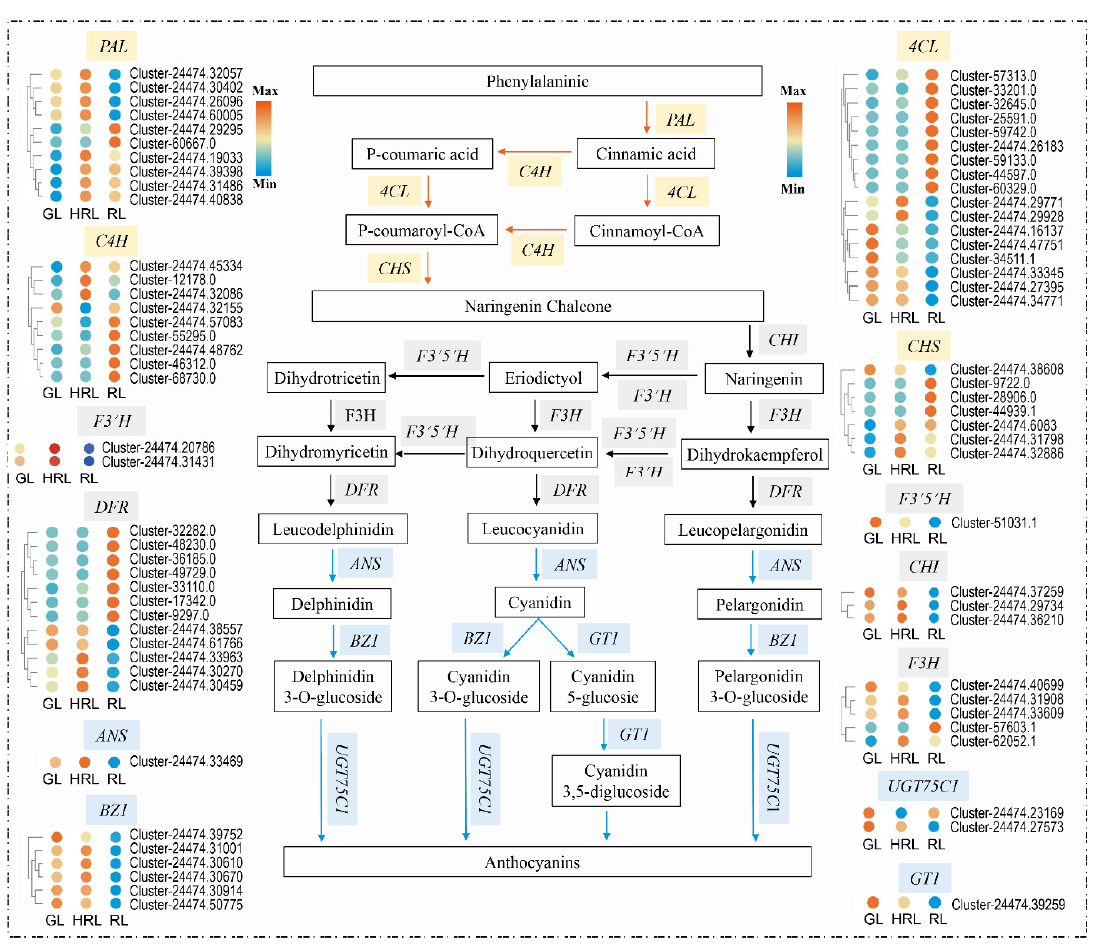
Figure 8. Pathways and key genes related to the biosynthesis pathways of phenylpropanoid, flavonoid, and anthocyanidin in A. triflorum , reconstructed based on KEGG pathway analysis of DEGs. The left and right colored dots displayed the level of expression of key genes in green (GL), orange (HRL), and red (RL) leaves; PAL, phenylalanine ammonia ‐ lyase; 4CL, 4 ‐ coumarate ‐ CoA ligase; DFR, dihydroflavonol 4 ‐ reductase; CHS, chalcone synthase; CHI, chalcone isomerase; F3H, flavanone 3 ‐ hydroxylase; F3 ′ H, flavanone 3 ′‐ hydroxylase; F3 ′ 5 ′ H, flavanone 3 ′ 5 ′‐ hydroxylase; DFR, dihydroflavonol 4 ‐ reductase; ANS, anthocyanin synthase; BZ1, anthocyanidin 3 ‐ O ‐ glucosyltransferase; GT, glucosyltransferase; UGT75C1, anthocyanidin 3 ‐ O ‐ glucoside 5 ‐ O ‐ glucosyltransferase.